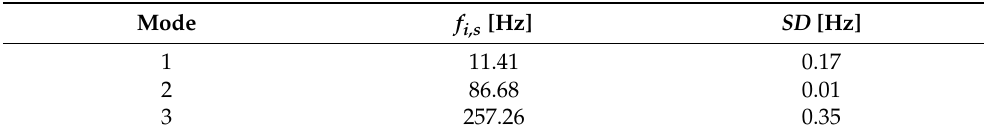
Figure 10. Considered eigenmode shapes for the cantilever beam. Table 5. Experimental eigenfrequencies of the cantilever beam and the corresponding standard de- viation (SD).